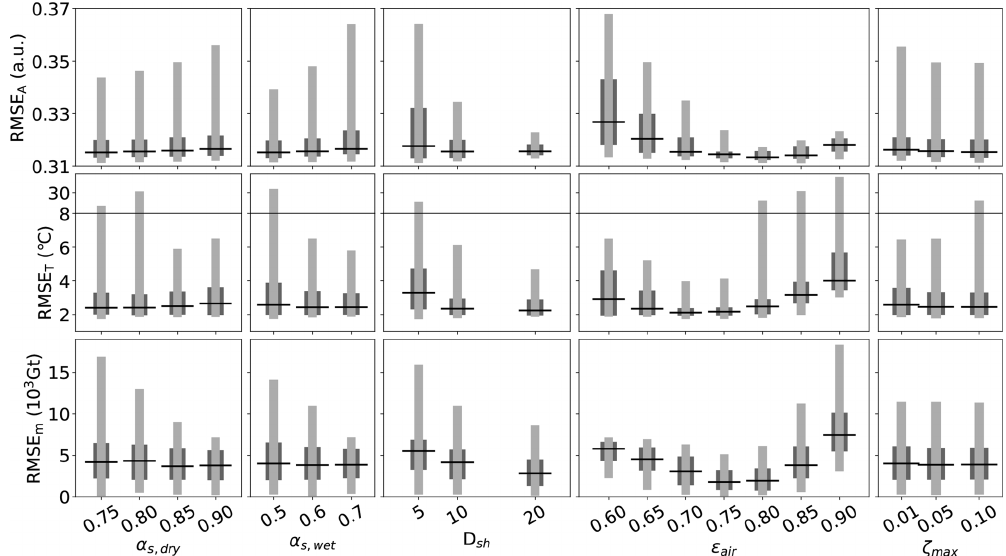
Figure 7. RMSE for monthly snow area A (top row), Greenland borehole temperature T (middle row; note the broken vertical scale), and Greenland mass balance m (bottom row), for five model parameters. Dark grey ranges contain 50% of the ensemble simulations; light grey is 90%. The horizontal black line shows the